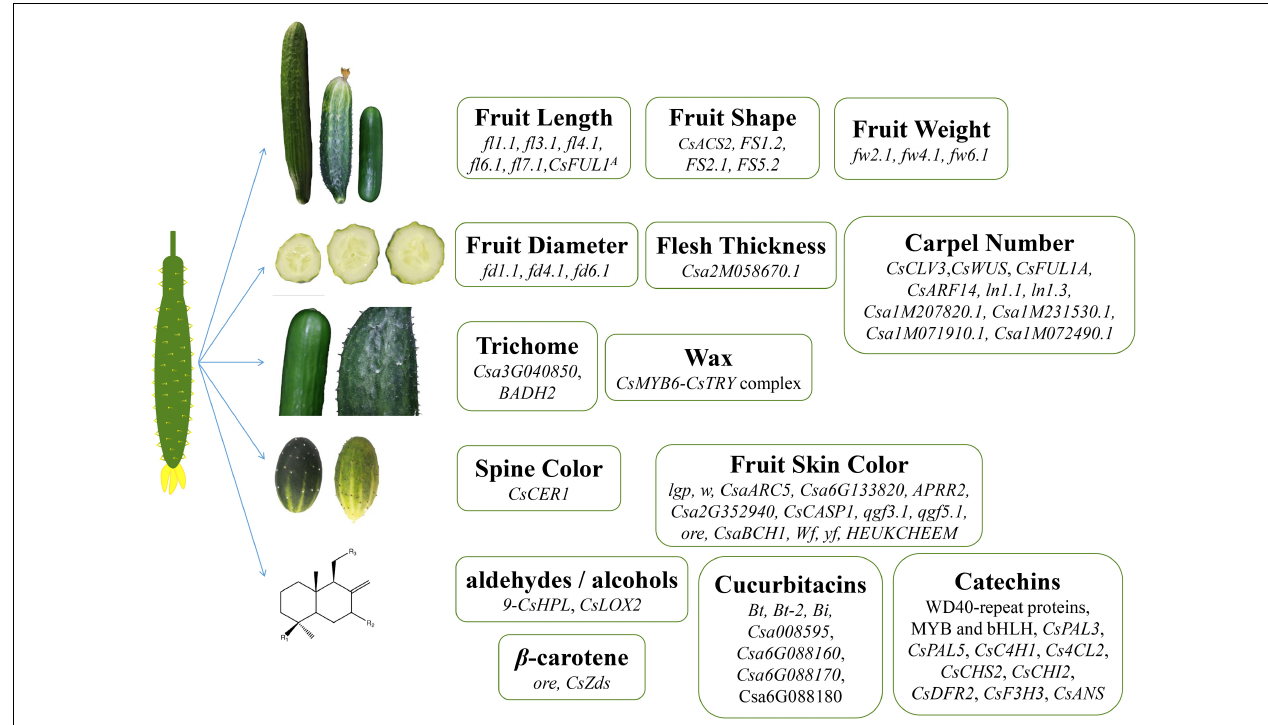
FIGURE 1 | Genes related to cucumber fruit quality. Genes regulating fruit length, fruit shape, weight, diameter, thickness, carpel number, trichome, wax, spine color, and synthesis of secondary metabolite in